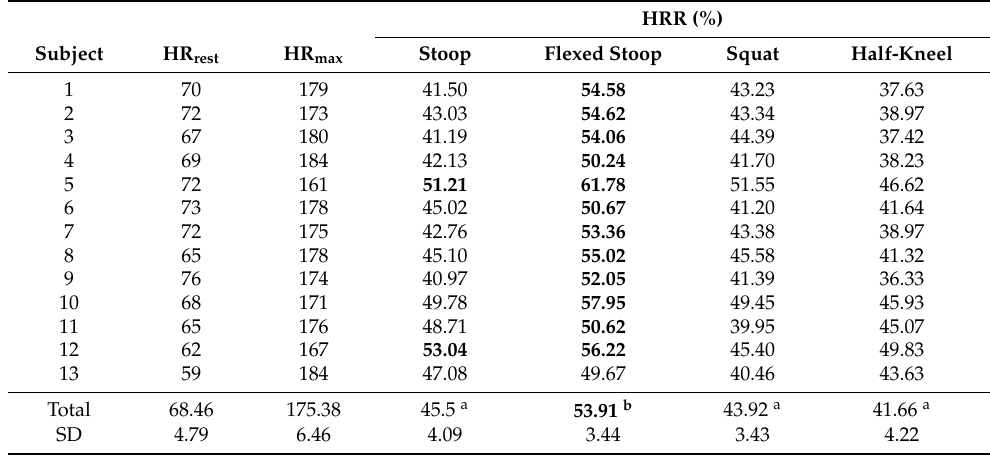
Table 6. Resting heart rate (HR rest ), maximum heart rate (HR max ), and relative heart rate (HRR) per study subject for the examined body postures.